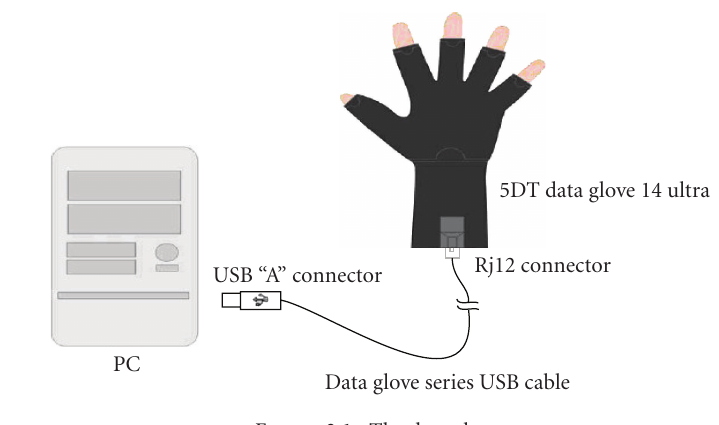
Figure 2.1 . The data